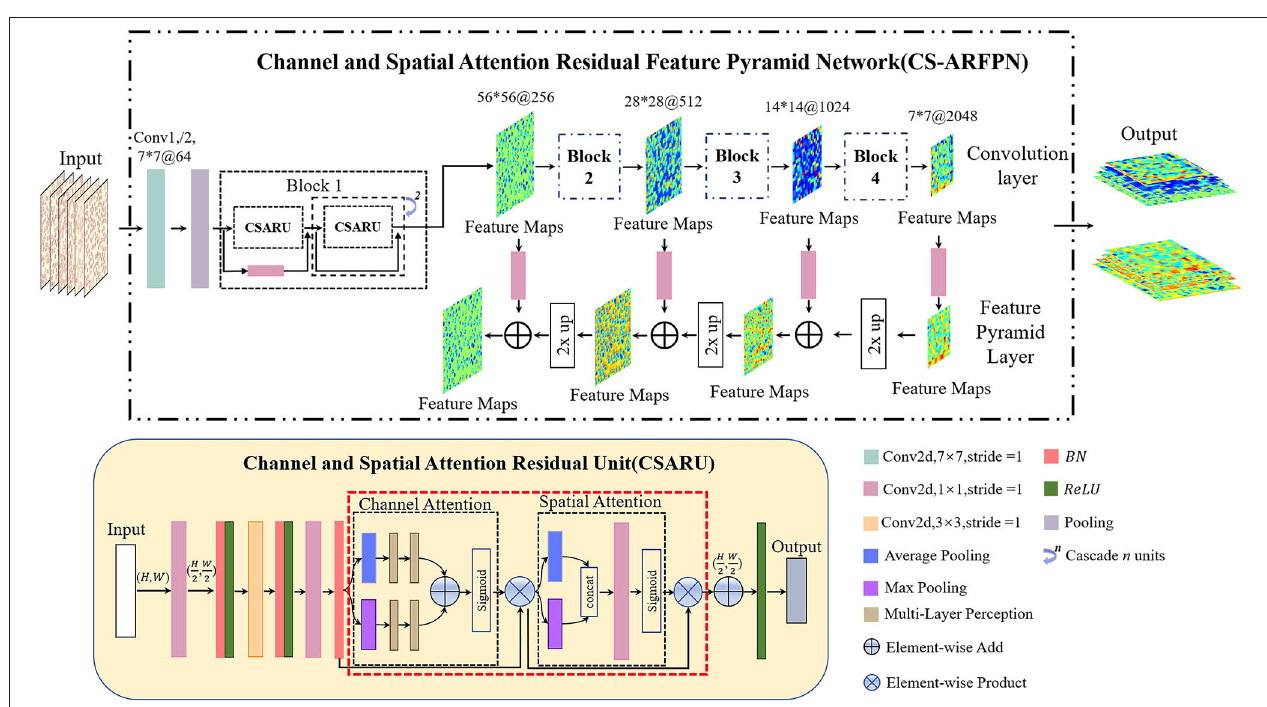
FIGURE 5 | Schematic diagram of the Channel and Spatial Attention Residual Feature Pyramid Network (CS-ARFPN) structure. This structure still uses ResNet-101 as the backbone. Channel and Spatial Attention Residual Units (CSAU) are located behind each residual congestion unit. They focus on the key and detailed features of the red blood cell